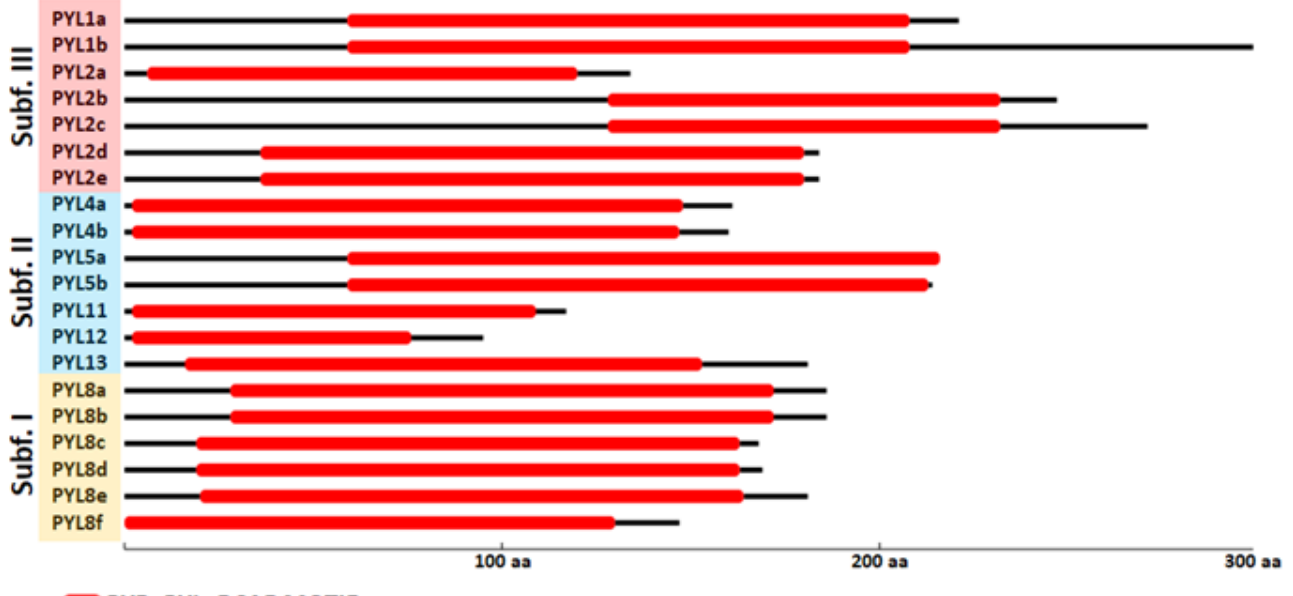
Figure 6. Conserved motifs analysis of CqPYL genes. The conserved motifs of the CqPYLs were identified using the MOTIF search tool. The MOTIF search was performed in pfam and NCBI-CDD databases. In red rectangles the PYR_PYL_RCAR motif domain (PYR_PYL-RCAR motif includes the Polyketide cyclase and the Bet_v1-like